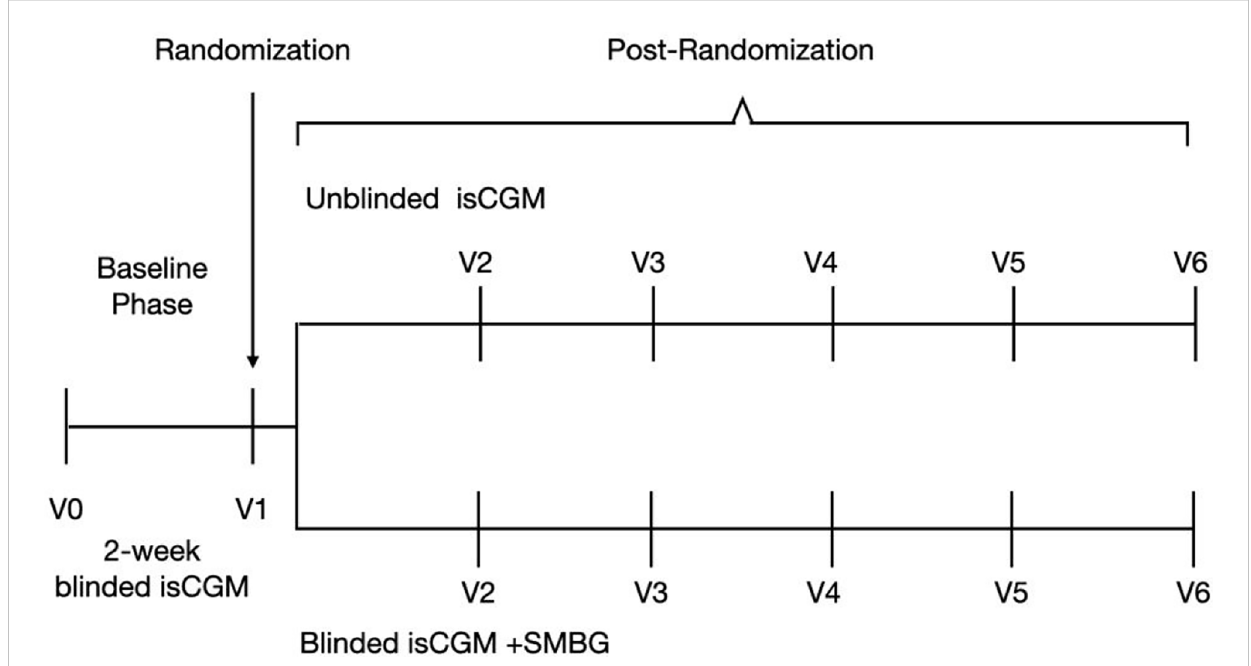
FIGURE 1 Study fl ow in a study of the ef fi cacy of unblinded and blinded intermittently fl ash continuous glucose monitoring on glycemic control in adults with type 1